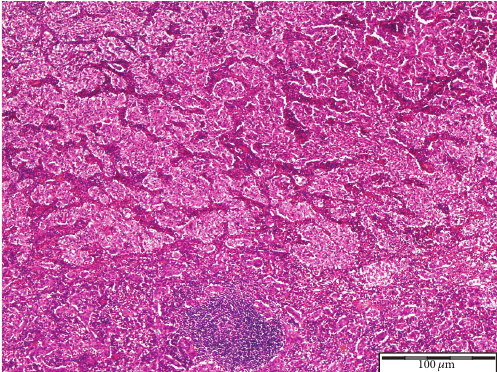
Figure 1: Lymphoepithelioma-like carcinoma of urinary bladder showingtumourcellsadmixedwithdenseinflammatorycomponent Haematoxylin and Eosin staining × 4 magnification reproduced from [3] (http://dx.doi.org/10.7707/hmj.v6i3.245) with permission